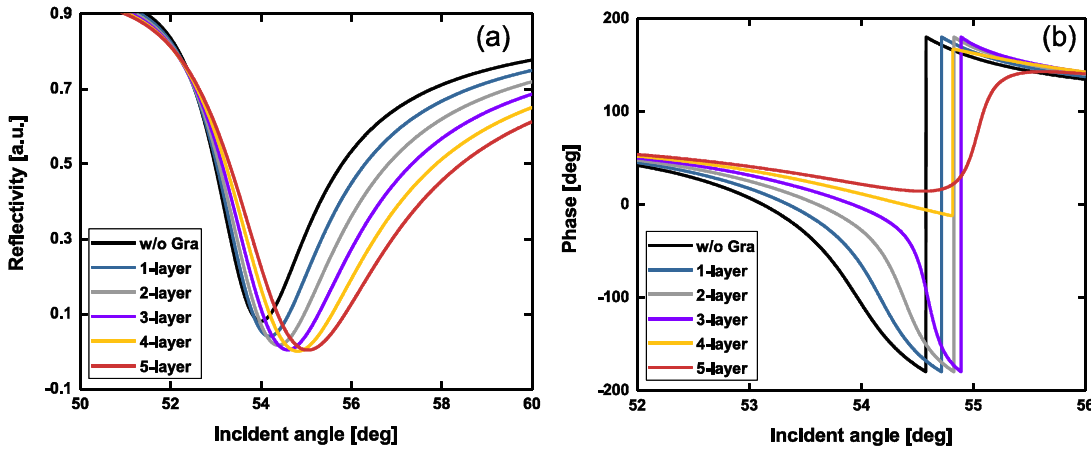
Figure 3. Variation of reflectivity ( a ) and phase ( b ) with respect to the incident angle by tuning the number of graphene overlayers ranging from 0 to 5 layers. The Au film thickness is 42 nm. The number of blue phosphorus layers is 2. The incident wavelength is 632.8 nm.